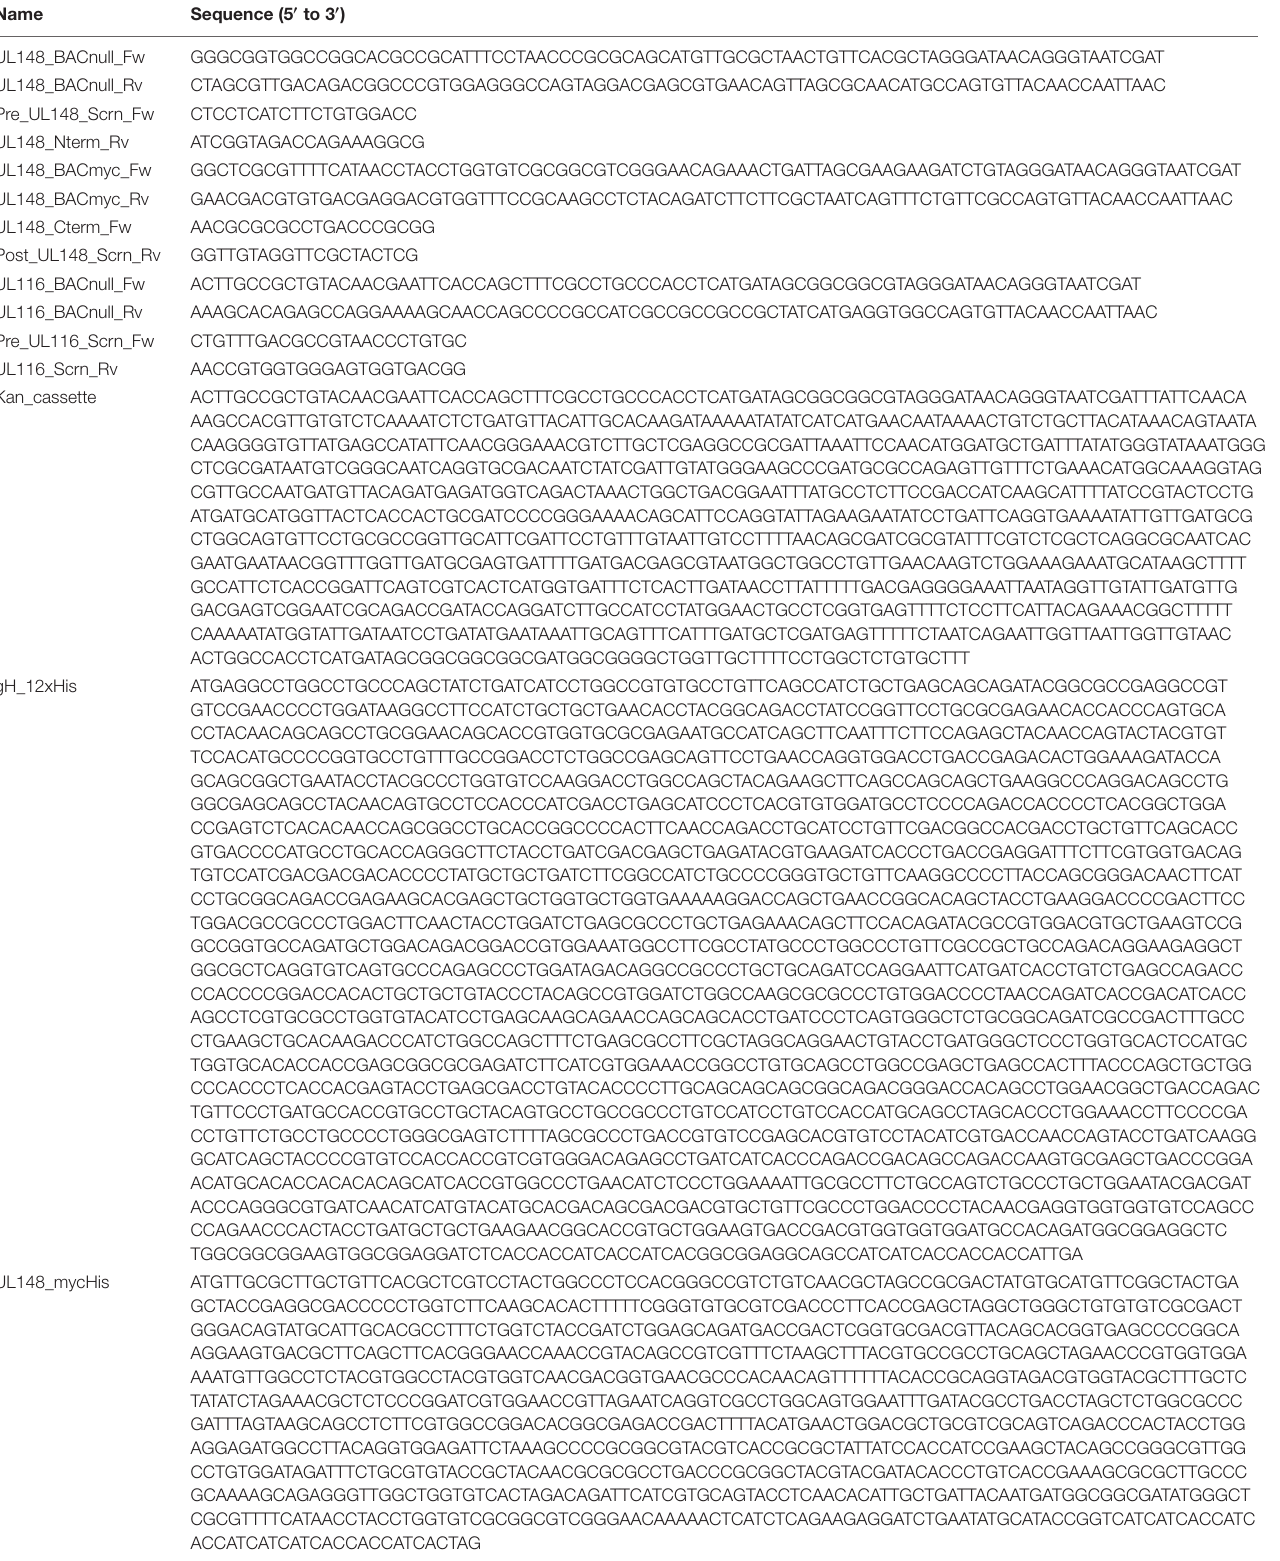
TABLE 1 | Oligonucleotides and synthetic DNA used in this